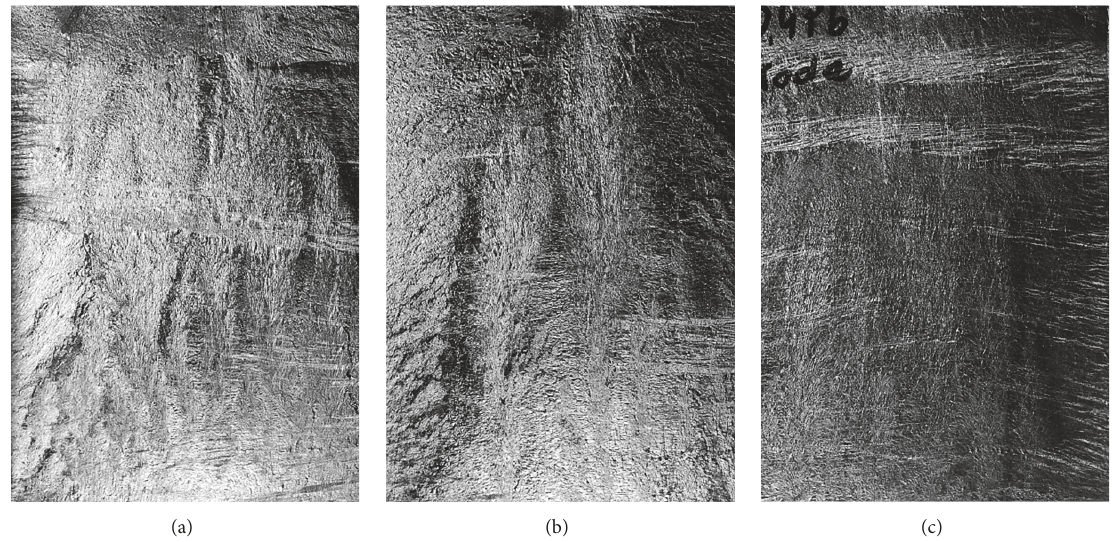
Figure 2: Visual appearance of water-cooled hot-dip galvanised surfaces: (a) Pb 1.2, (b) Pb 0.8, and (c) Pb 0.4.